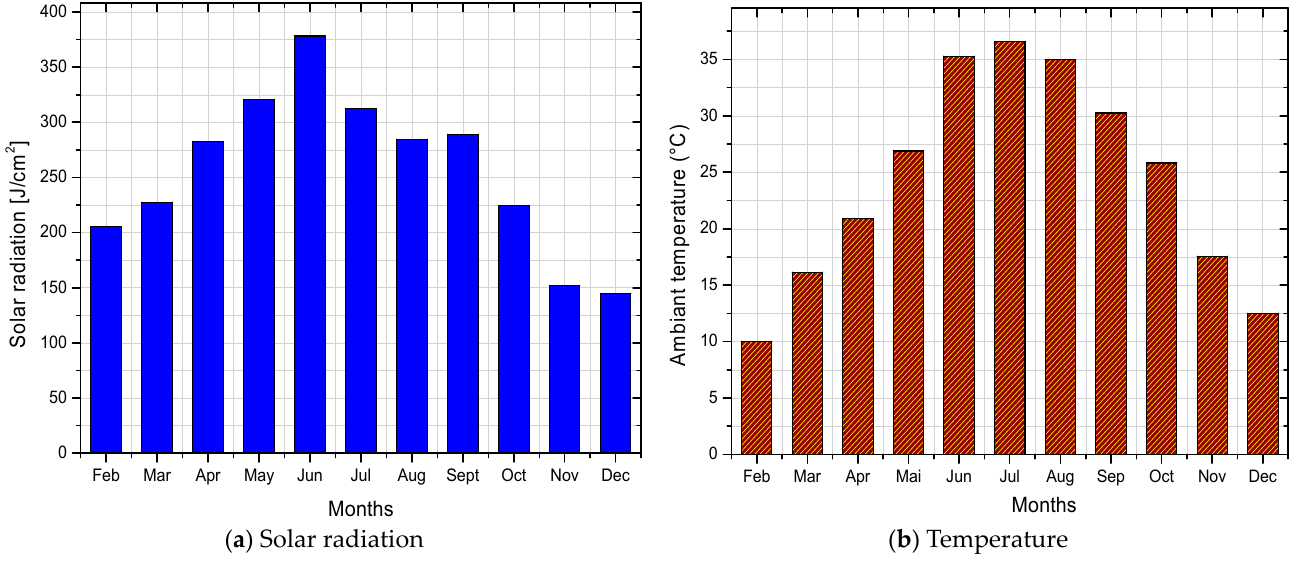
Figure 5. Annual solar radiation and ambient temperature evolution (Ghardaïa site).